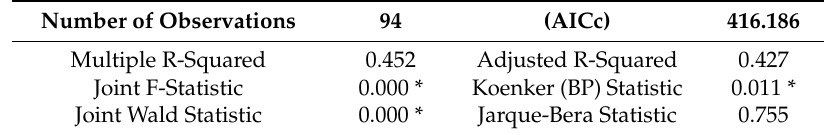
Table 6. Overall model statistic results.